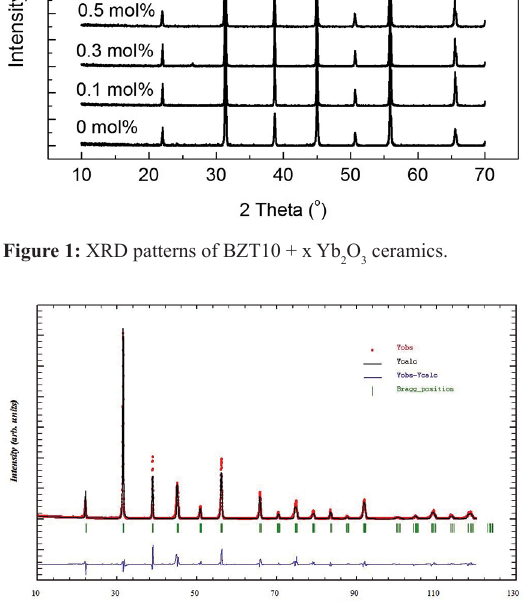
Figure 2: The Rietveld plot of the X-ray diffraction pattern of